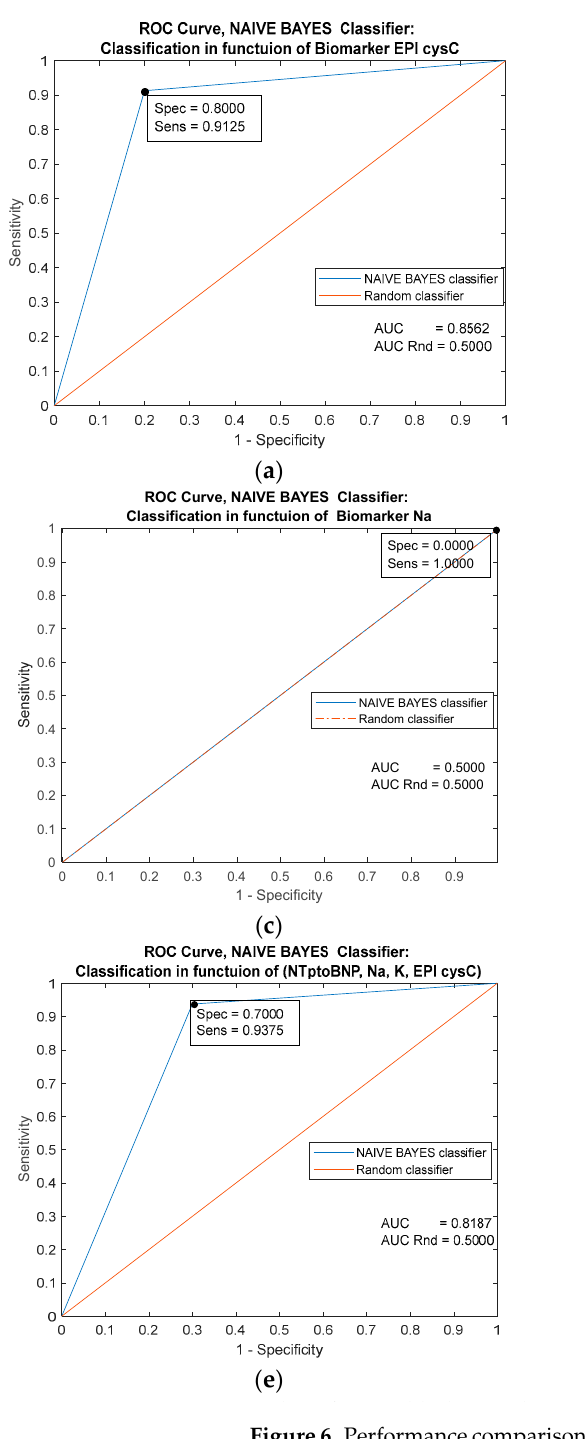
ROC Curve, NAIVE BAYES Classifier: Classification in functuion of Biomarker Na